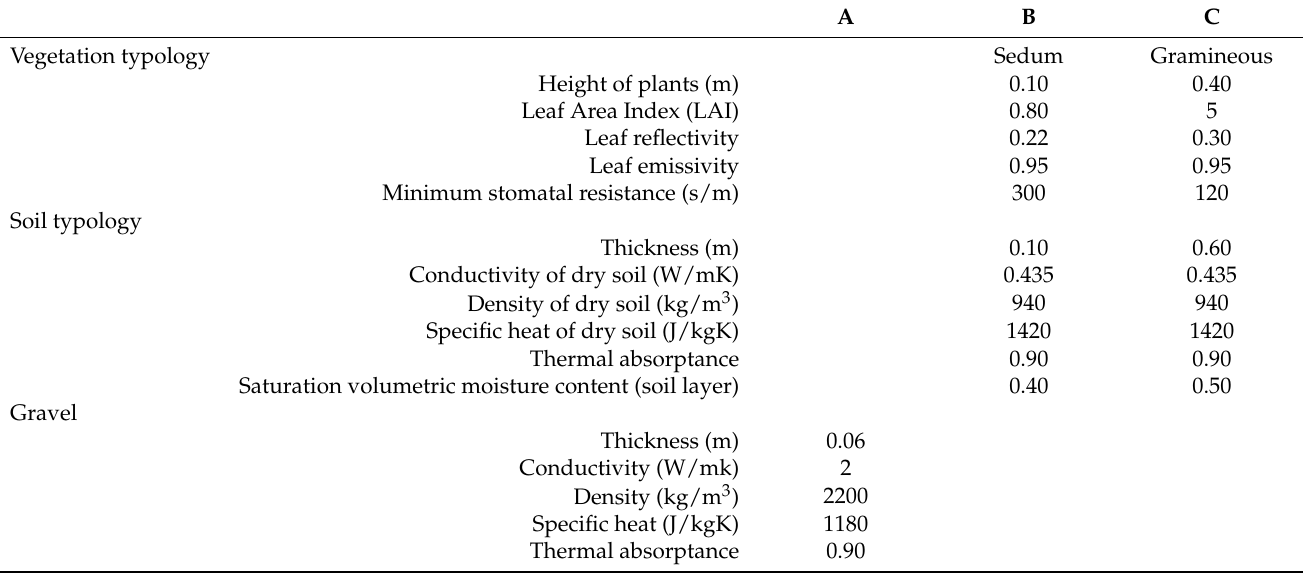
Table 3. Main characteristics of the three roof models’ finishes proposed for